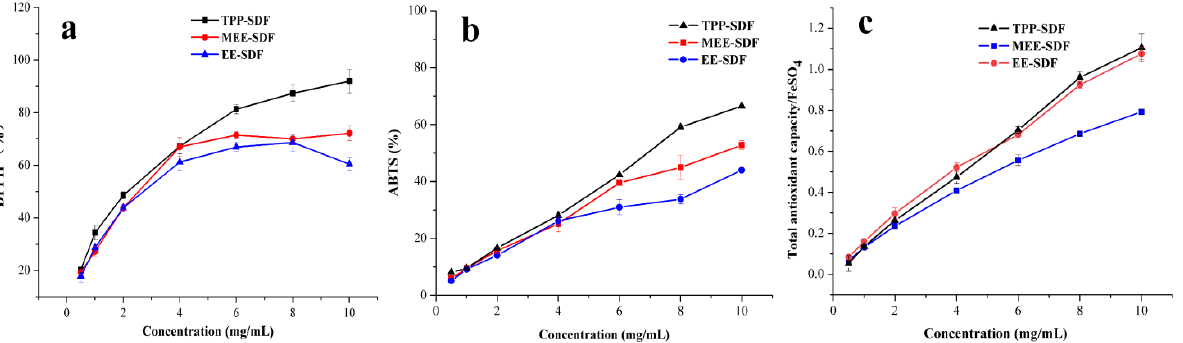
Figure 3. Antioxidant activity of SDFs obtained with different extraction methods. DPPH ( a ), ABTS free radical scavenging ability ( b ), and FRAP ( c ).